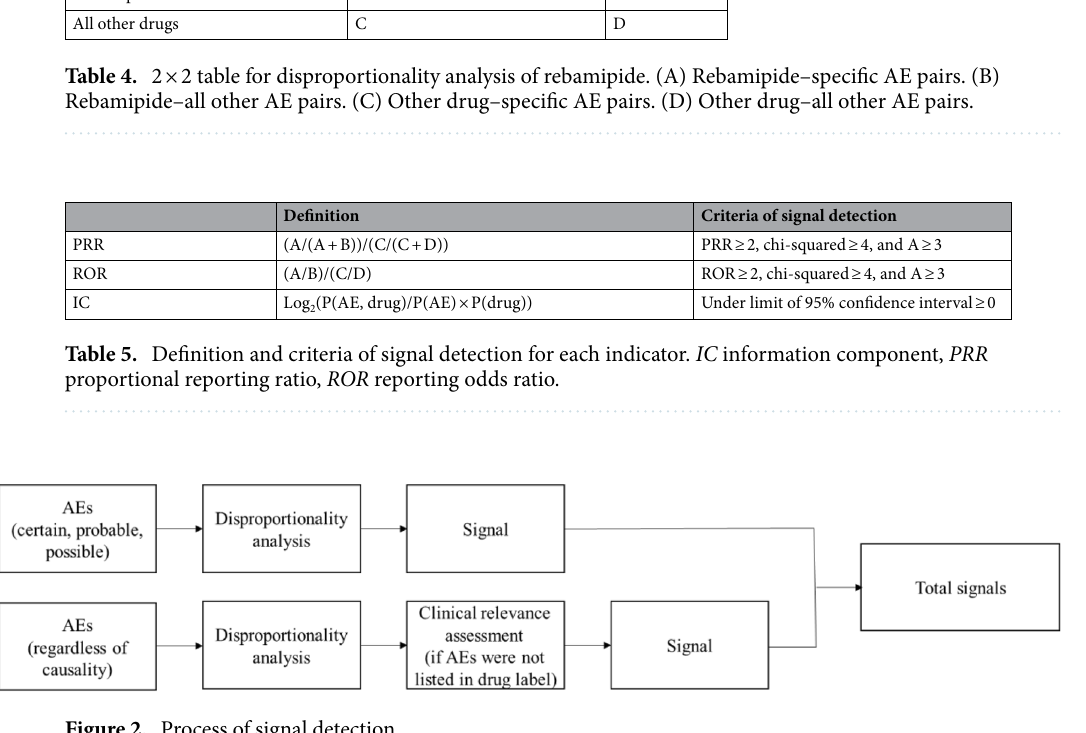
Figure 2. Process of signal